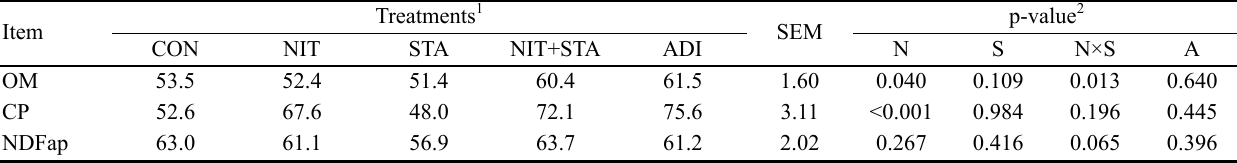
Table 4. Least squares means (%) of total digestibility of organic matter (OM), crude protein (CP), and neutral detergent fiber corrected for ash and protein (NDFap) according to the treatments